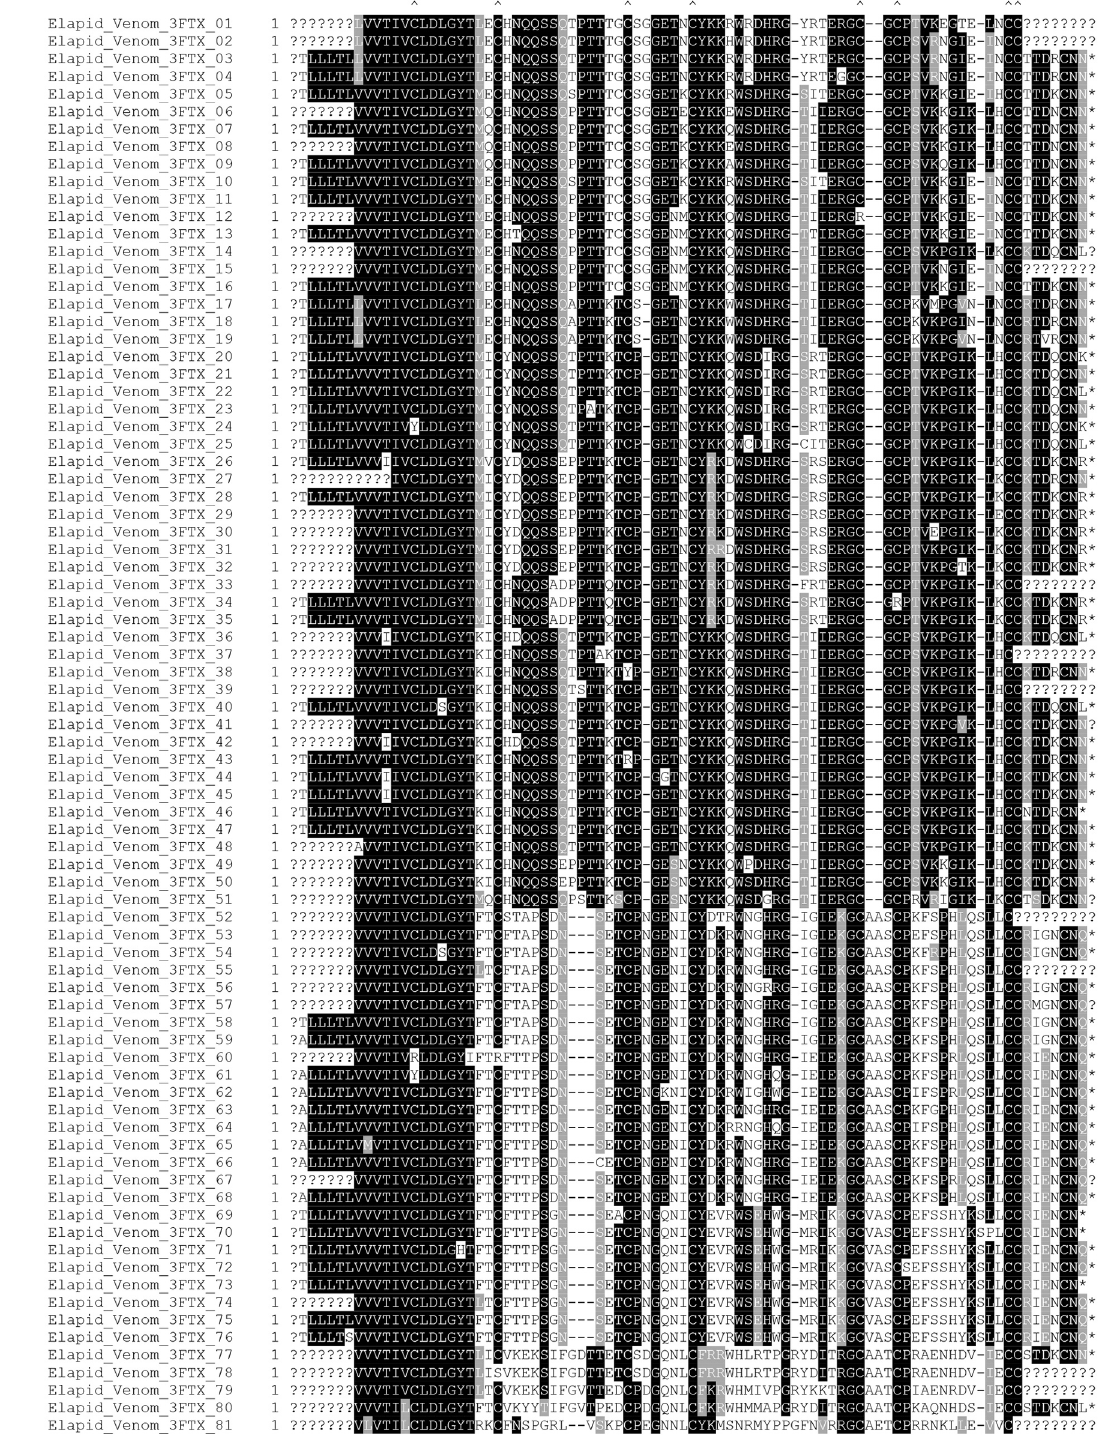
Fig 5. Multiple sequence alignment of elapid three-finger toxin amino acid sequences translated from transcripts from V TRZ . Three-finger toxin amino acid sequences translated from transcripts isolated from the V TRZ of the